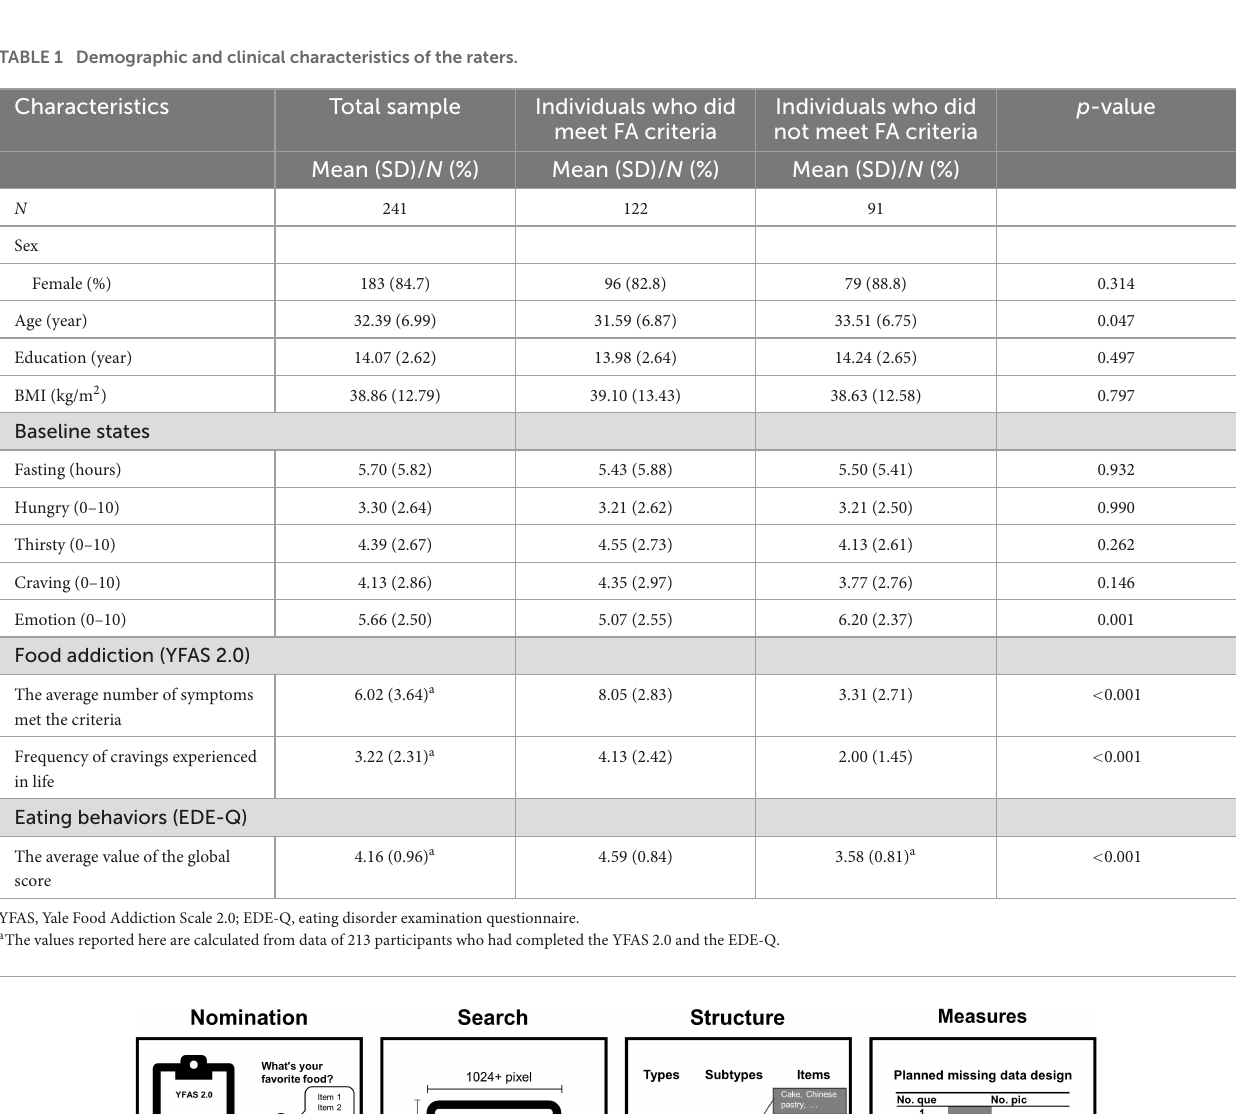
TABLE 1 Demographic and clinical characteristics of the raters. Characteristics Total sample Individuals who did